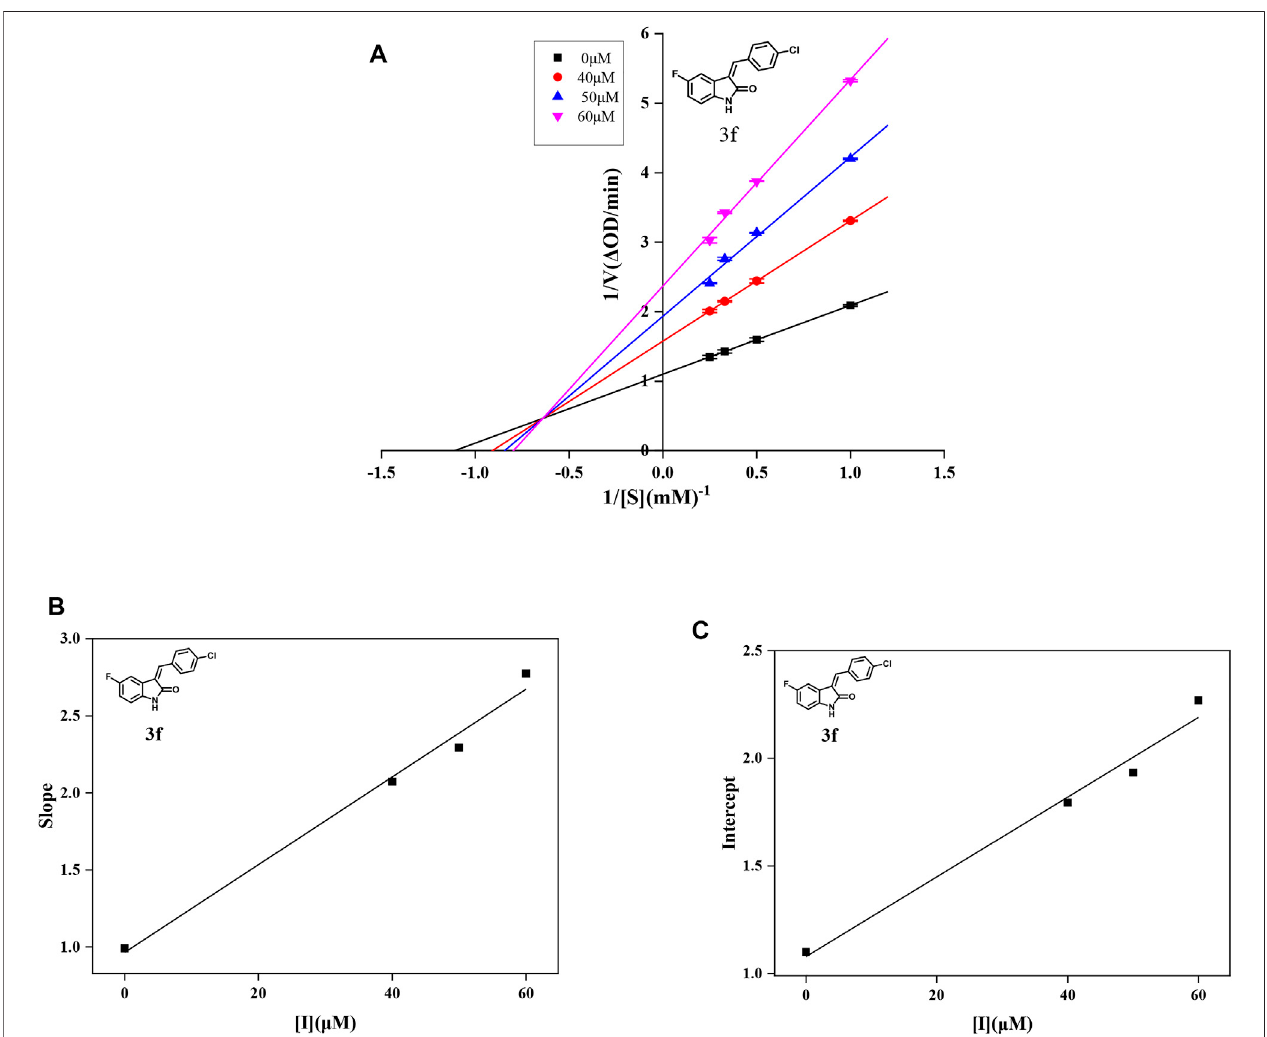
FIGURE2|(A) Lineweaver – Burkplotsofcompound 3f on α -glucosidase. (B) Plotofslopevs.theconcentrationofcompound 3f forthecalculationoftheinhibition constant K I . (C) Plot of intercept vs. the concentration of compound 3f for the determination of the inhibition constant K IS .